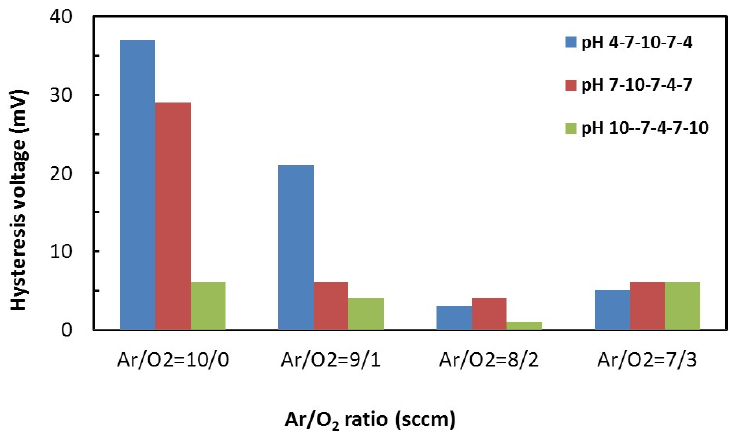
Figure 6. Hysteresis versus Ar/O 2 gas ratios (sccm) for different pH